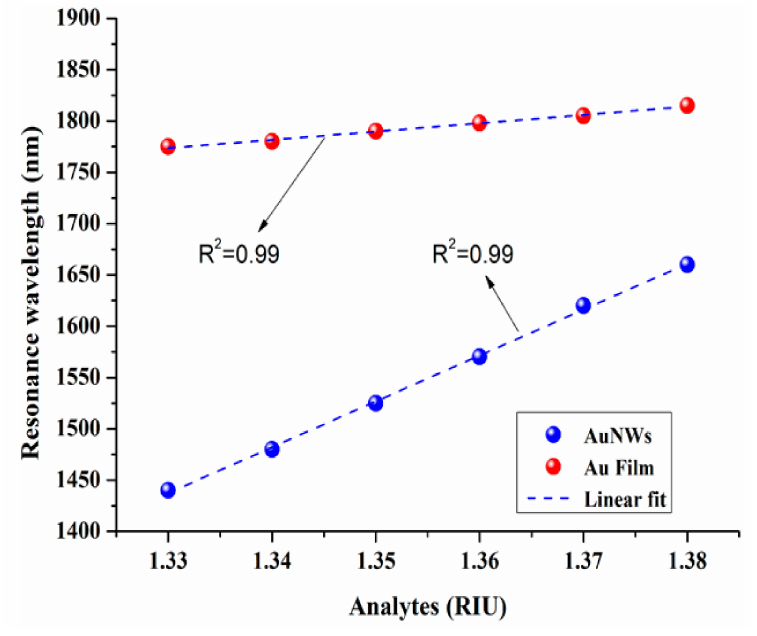
Figure 8. Sensitivity plot of the designed sensors for both AuNWs and Au film. Table 2. Sensitivity comparison of various reported sensor based on metallic